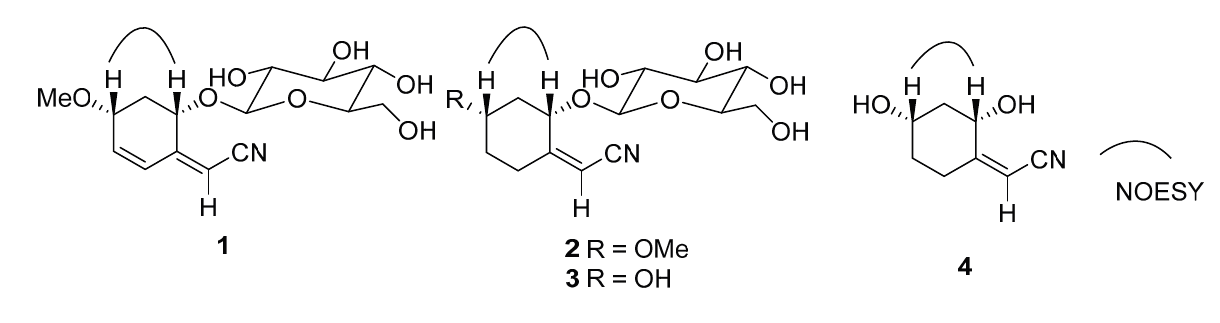
Figure 2. Selected 1 H- 1 H COSY and HMBC correlations of 1 – 4 .